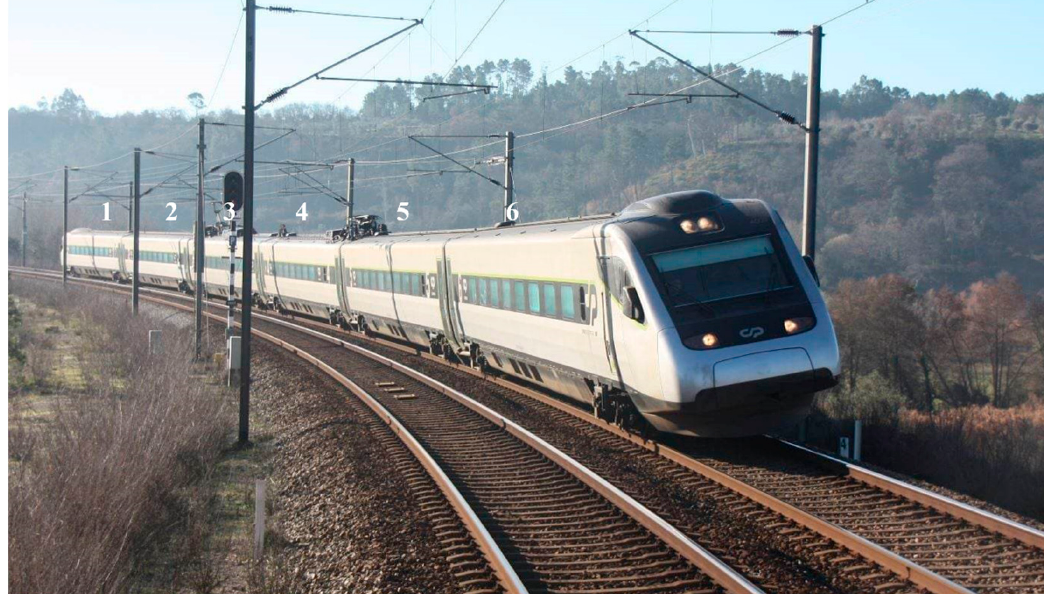
Figure 3. CPA 4000 series train in operation.